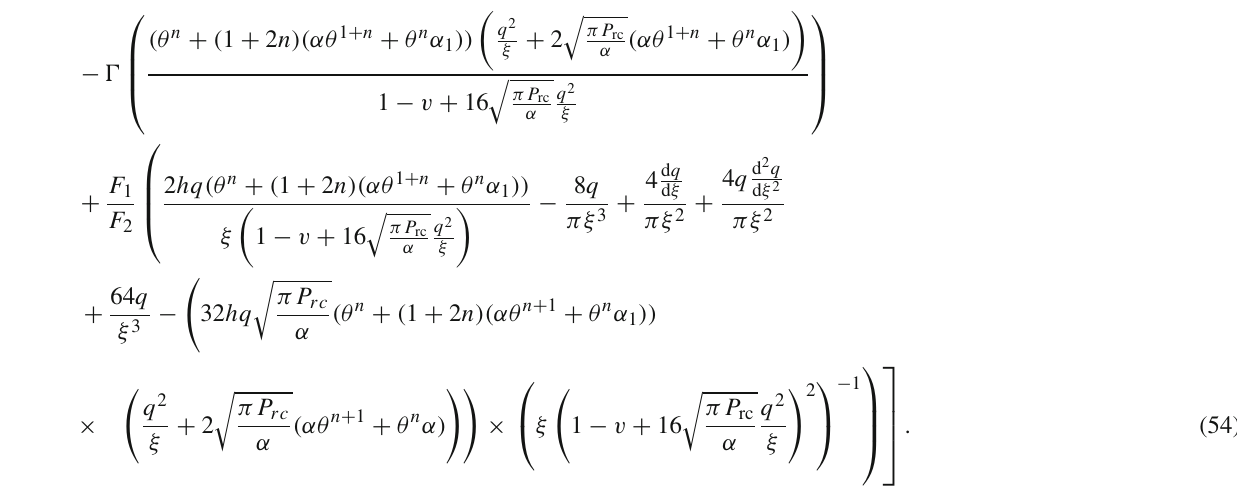
will use the above equation to plot the force distribution δ R 3 δ against x to observe cracking (overturning) of function n polytropes. Figures 5,6 and 7 represent the cracking of rel- ativistic anisotropic cylindrical polytropes corresponding to case